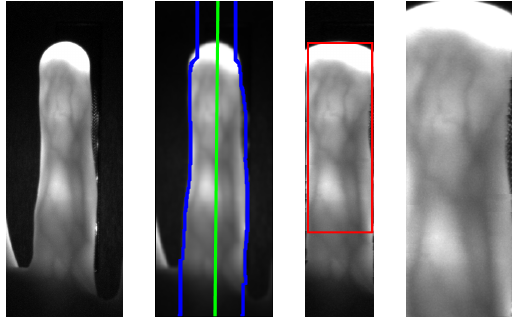
Figure 8. Finger vein region of interest (ROI) extraction process, from left to right: input image, finger outline and centre line detection, finger aligned, masked and normalised ROI boundary, final